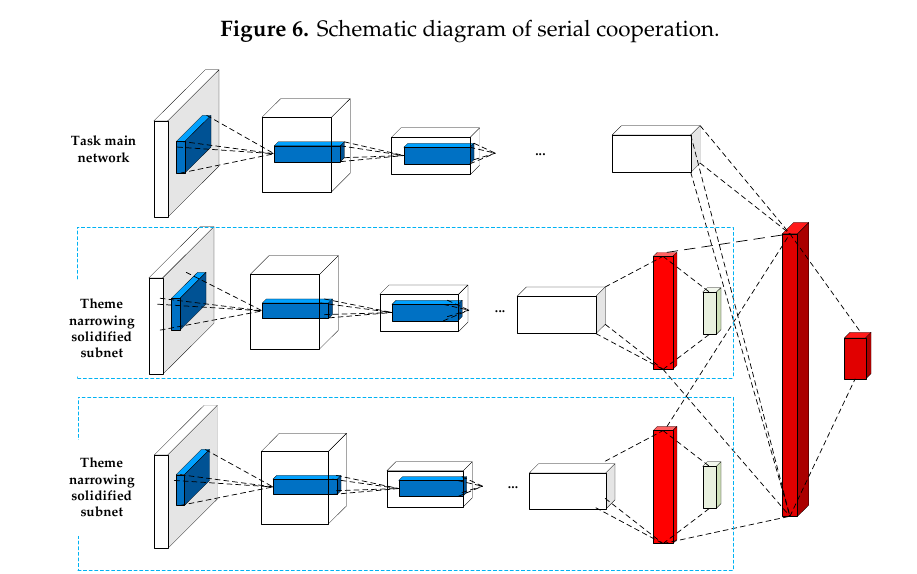
Figure 6. Schematic diagram of serial cooperation.